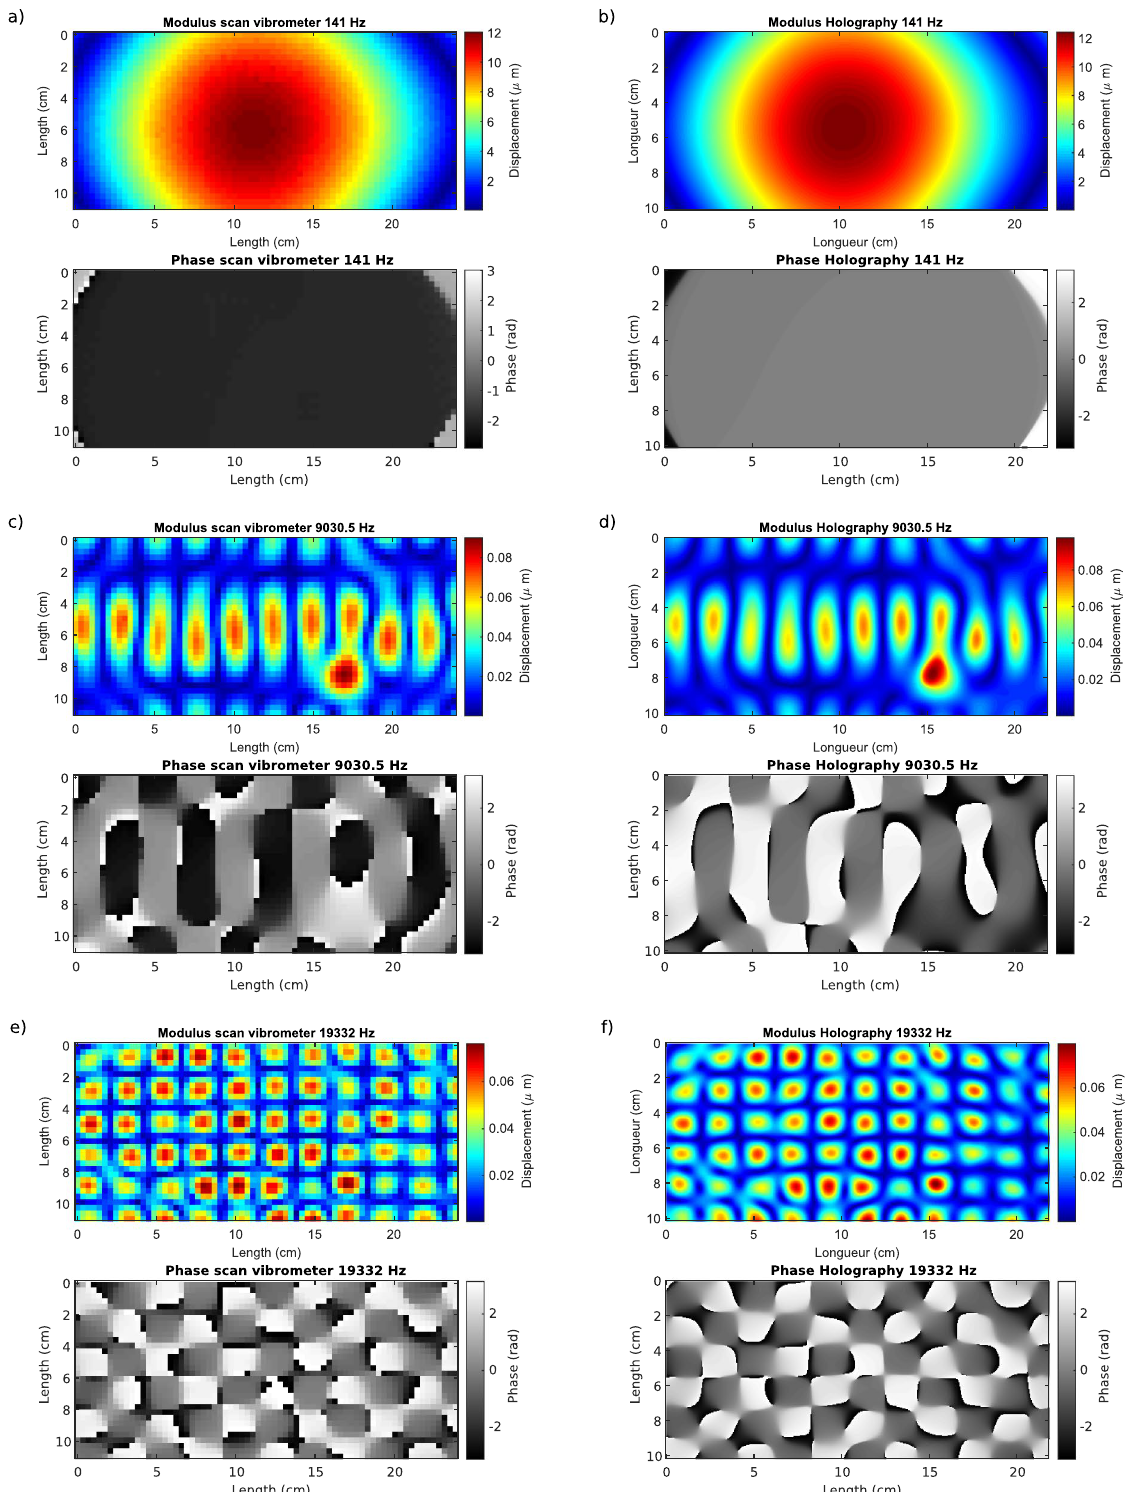
Figure 1. Amplitude and phase of the operational displacement fields of the structure measured with scanning point-wise laser Doppler vibrometer at (a) 141 Hz, (c) 9030.5 Hz, (e) 19332 Hz, and coherent imaging at (b) 141Hz, (d) , 9030.5Hz, (f)